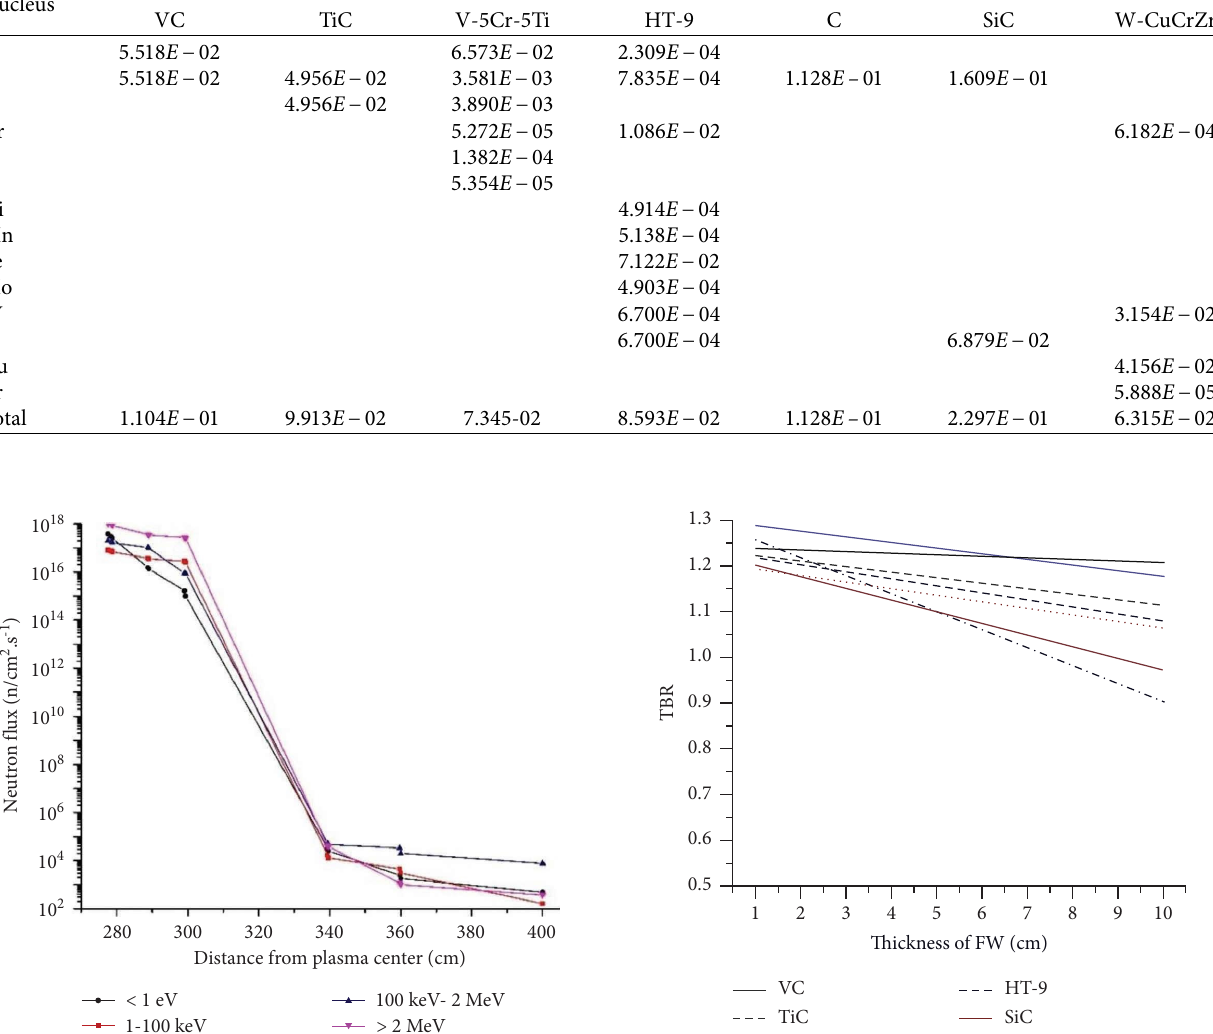
Nuclei density (atom/barn.cm)